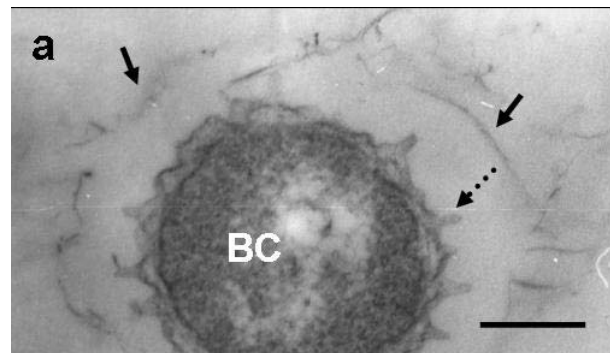
Figure 4. TEM images of U/Pb-stained sections of bacterial cells associated with the immature sheath incubated in the groundwater for 1–3 days. ( a ) At day 1, protuberances (dotted arrow) originated from the cell envelope and a few fibrous structures of immature sheath (arrow) surrounded the bacterial cell (BC) across the intervening space; ( b ) At day 2, an immature sheath of intermingled fibrils developed with some electron dense coagulates; ( c ) At day 3, the immature sheath comprised extremely electron-dense intermingled fibrils, suggesting heavy deposition of aqueous-phase metals. A relatively electron-lucent inner layer of a sheath with parallel-lined fibrils was distinguished in a few sheaths (inset, arrow). Scale bars = 200 nm, but 100 nm in (c)